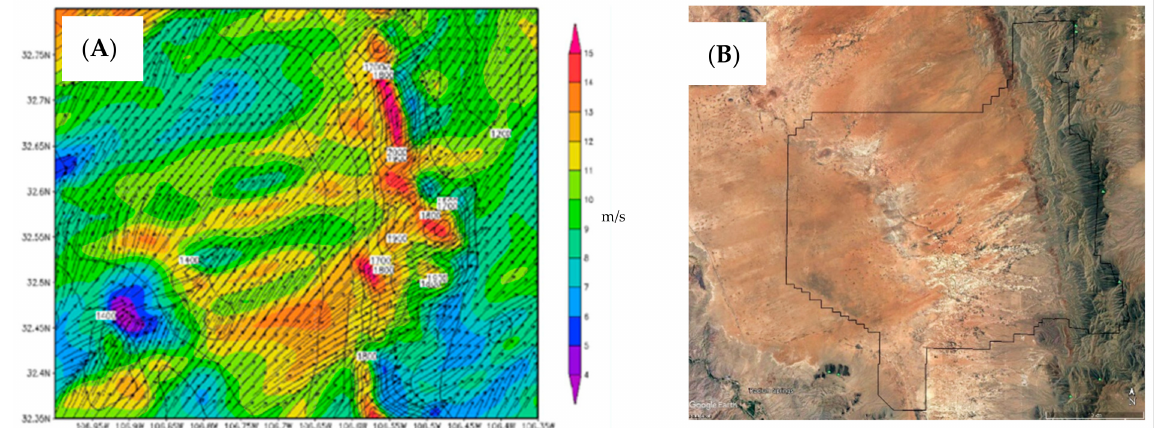
Figure 2. ( A ) Wind streaks in the surface horizontal wind velocity ( U ) on a 10 May 2015 WRF run. ( B ) Similarly oriented longitudinal streak patterns in the Jornada Experimental Range (JER)